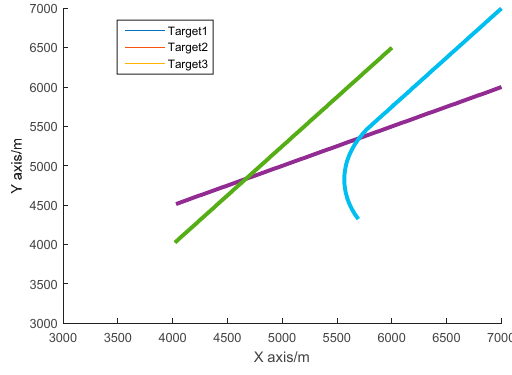
Figure 5. The true trajectories of 3 targets.